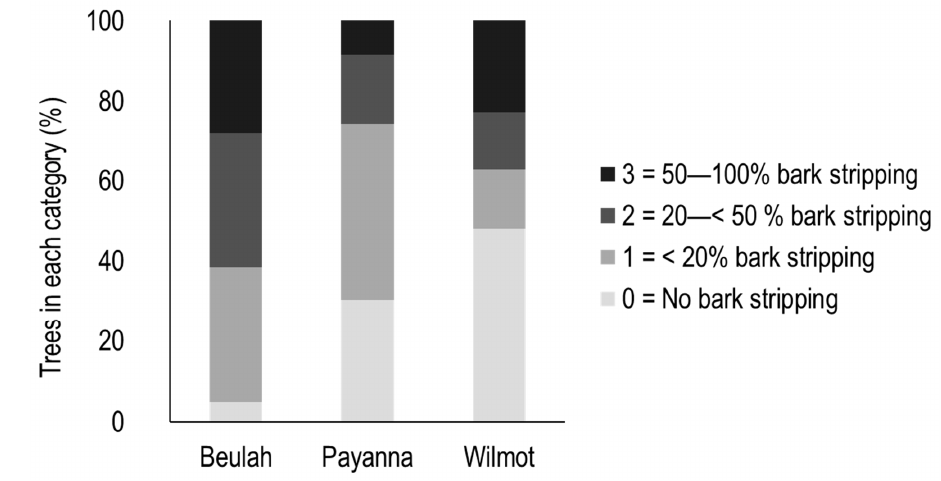
Figure 3. The percentage of trees in each bark stripping category at the three field trials—Beulah (in 2016, age 5 years), Payanna (in 2016, age 5 years), and Wilmot (in 2017, age 2 years).